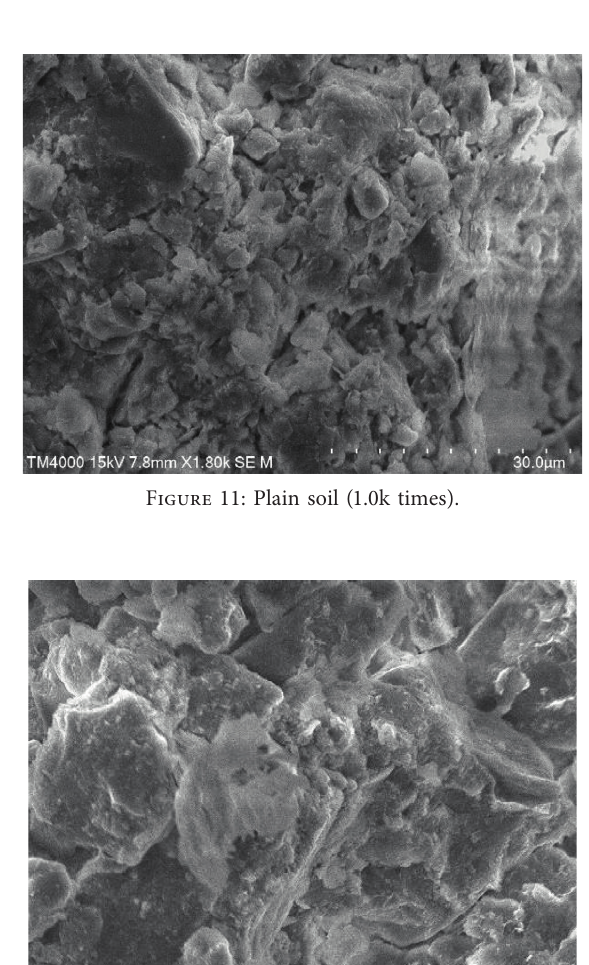
Figure 10: Typical failure characteristics of fiber-reinforced soil. (a) Unreinforced. (b) 0.1% fiber content. (c) 0.4% fiber content. (d) 0.6% fiber content.